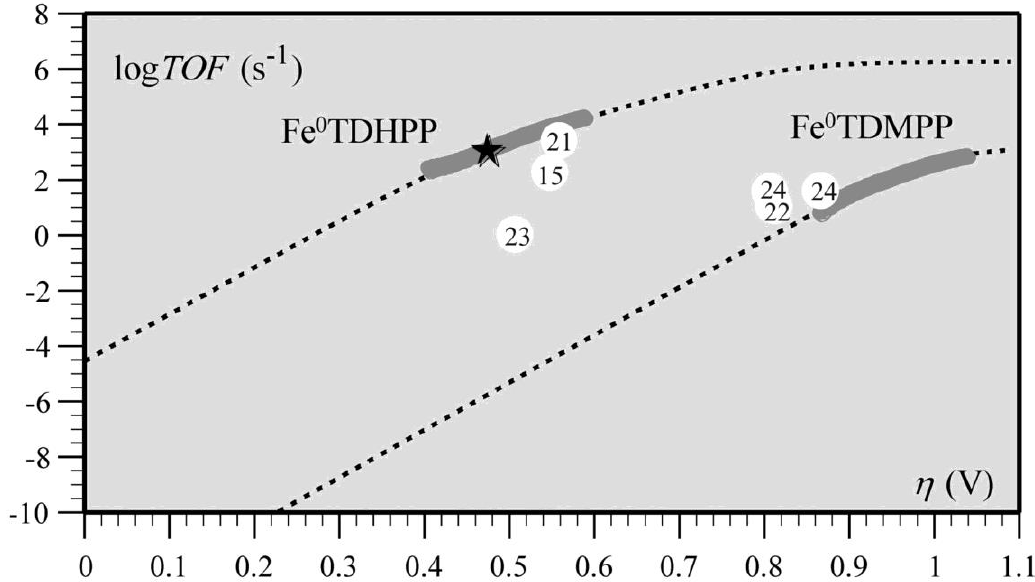
Figure 11. Correlation between turnover frequency and overpotential for the series of CO 2 -to-CO electroreduction catalysts. The star indicates TOF and η values from preparative-scale experiments of Fe 0 TDHPP. Reprinted from Ref. [77], copyright (2012), with permission from the American Association for the Advancement of Science.